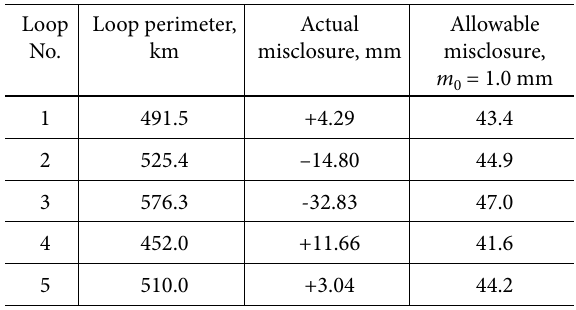
Table 3. Misclosures of loops of the Lithuanian